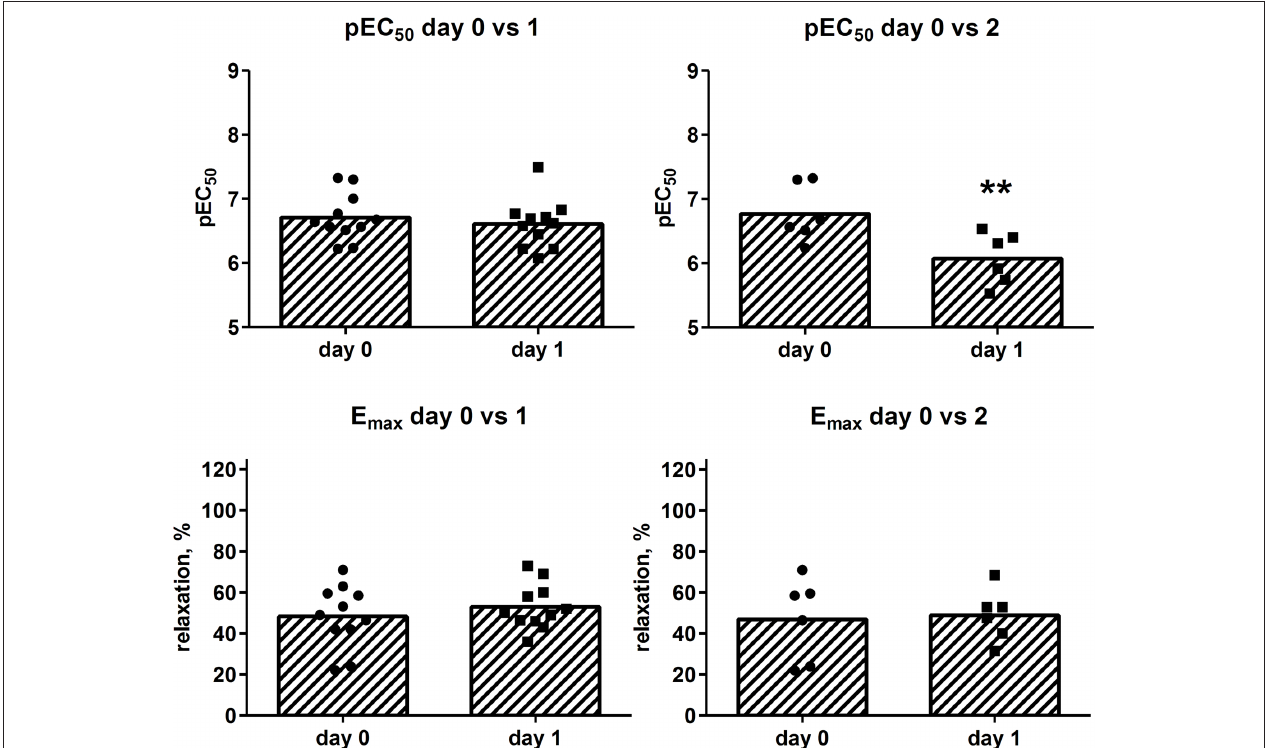
Figure 5 | effect of storage on relaxant responses to isoprenaline, from six patients for the day 0 vs. 2 comparison), whereas the bars represent expressed as potency ( p eC ) and efficacy ( E ) as calculated per strip. the group means. Note that the day 0 patients in the upper panel are not 50 max Strips were tested on the day of surgical removal (day 0) or 1 or 2 days later (day necessarily the same as in the lower panel, as each panel only shows patients 1 and 2). Each data point represents one patient (16 and 15 strips, respectively, for whom data on both days were available. ** p < 0.05 in a paired, two-tailed from 11 patients for the day 0 vs. 1 comparison; 10 and 10 strips, respectively, t -test vs. corresponding data from day